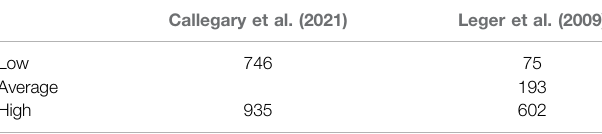
TABLE 1 | Potential soil carbon storage as a result of RDS-based riparian restoration, reported in studies by Callegary et al. (2021) and Leger et